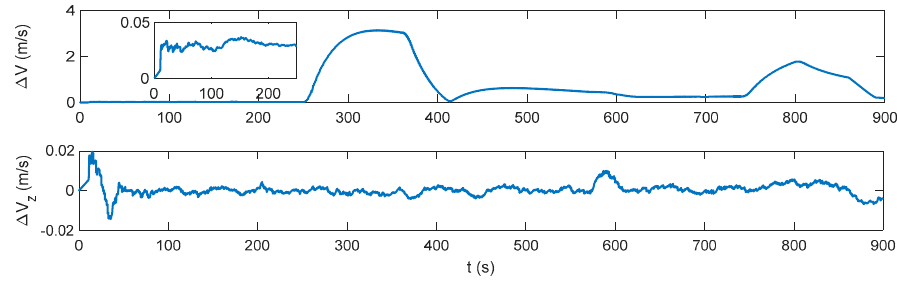
Figure 7. Velocity error of the INS/ZUPT solution.